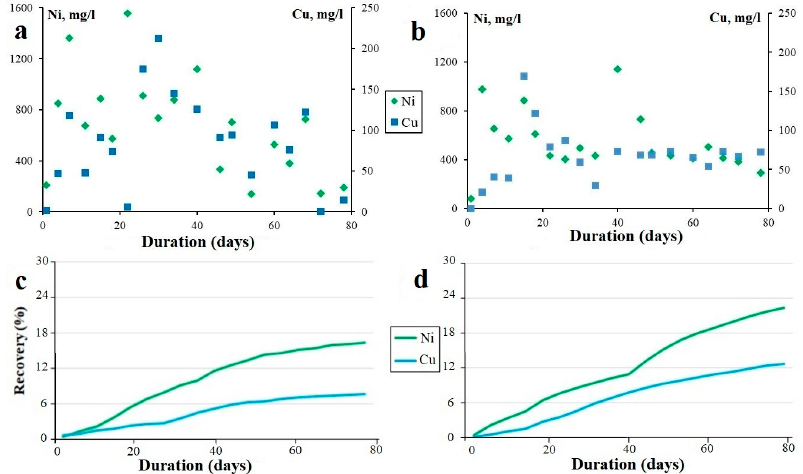
Figure 3. The concentration of metals in pregnant liquors during ore bioleaching: ( a ) Allarechensk TD, ( b ) Nud II. Recovery of metals into solution during the experiment: ( c ) Allarechensk TD, ( d ) Nud II. Table 1. Chemical composition of the Allarechensk TD